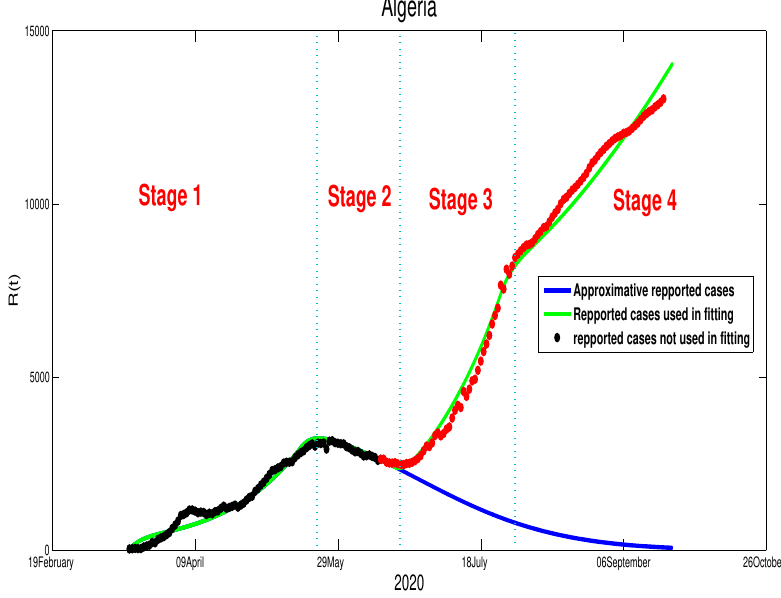
Figure 10. The new fitting of the data for the COVID-19 in Algeria after the relaxation of the population mobility restrictions.